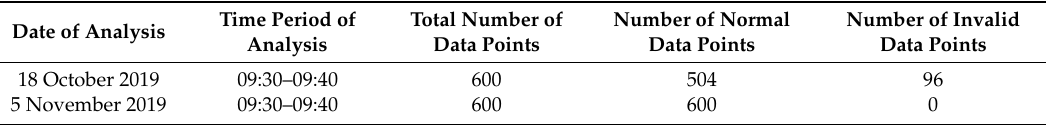
Table 5. Transformer E data validity analysis results.